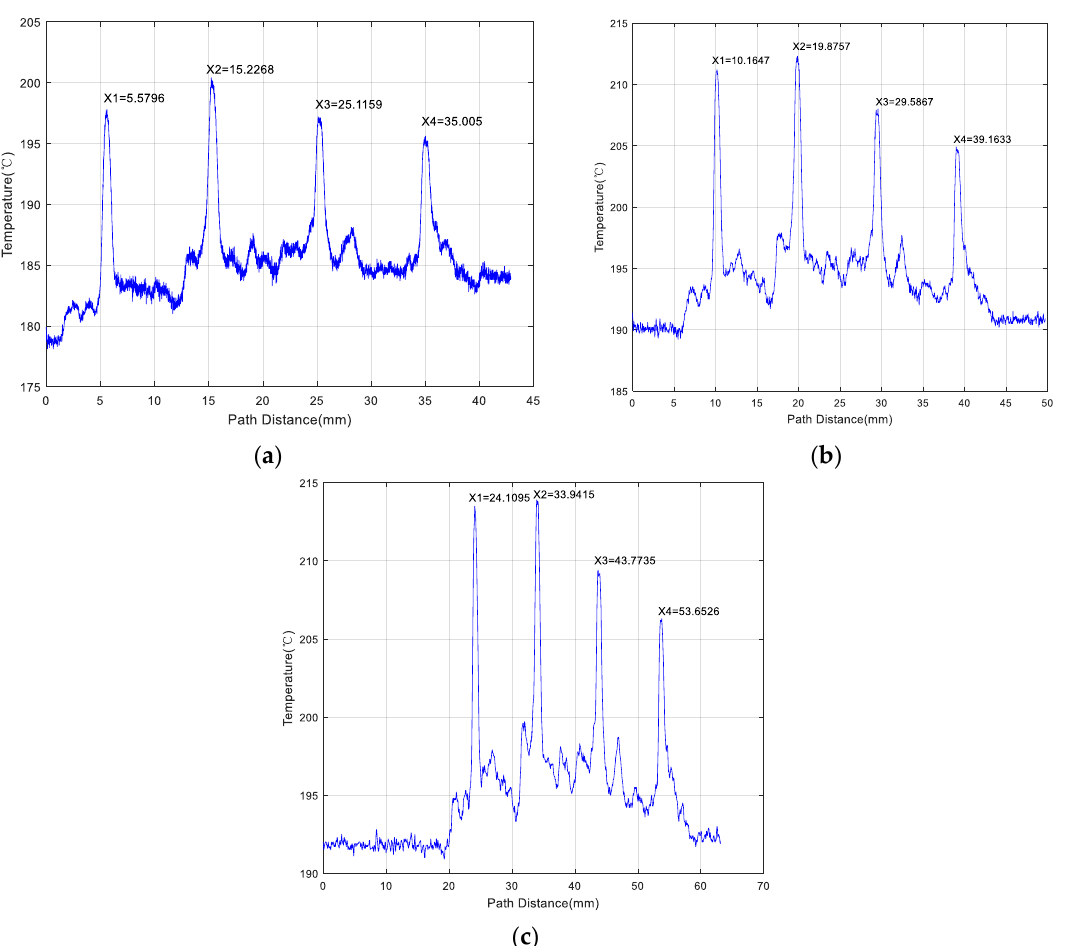
Figure 12. Temperature waveforms obtained along the positive direction of the LMD-316L austenitic stainless-steel sample upper surface at a scanning speed of ( a ) 1.0 mm/s; ( b ) 5.0 mm/s; and ( c ) 10.0 mm/s.